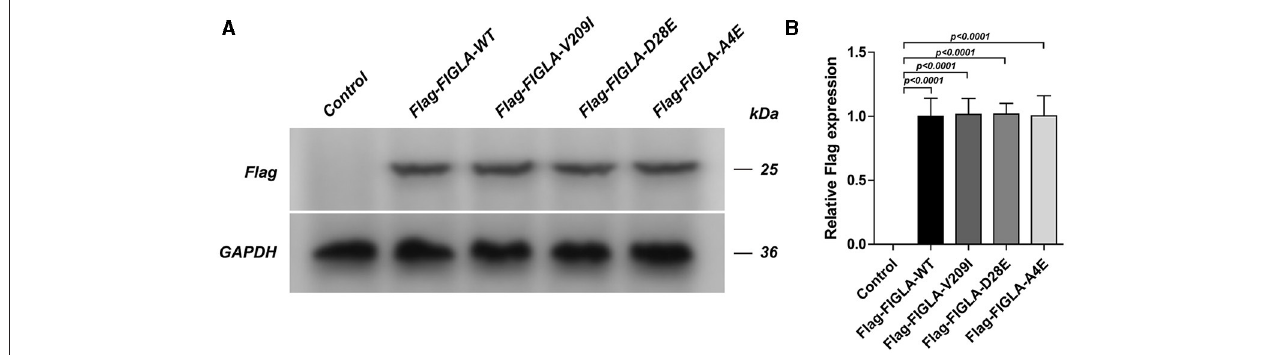
FIGURE 2 | HEK293 cells transfected with Flag-FIGLA-WT, Flag-FIGLA-V209I, Flag-FIGLA-D28E, or Flag-FIGLA-A4E. The transfection efficiency was detected by western blot assay (A,B) . Results were mean ± SD for three individual experiments which, for each condition, were performed in triplicate.